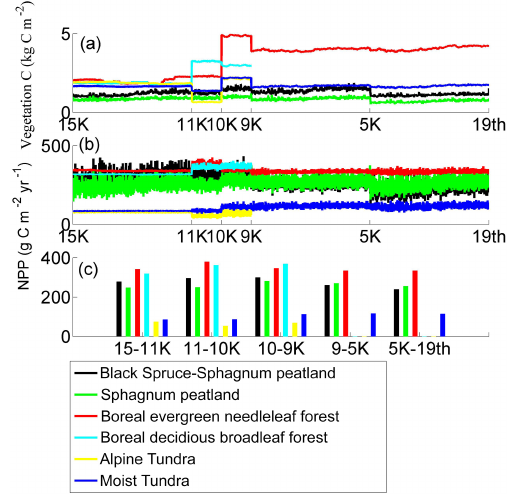
Figure 5. Simulated (a) mean vegetation carbon density (kgCm − 2 ) of different vegetation types, (b) annual NPP (gCm − 2 yr − 1 ) , and (c) long-term NPP (gCm − 2 yr − 1 ) .